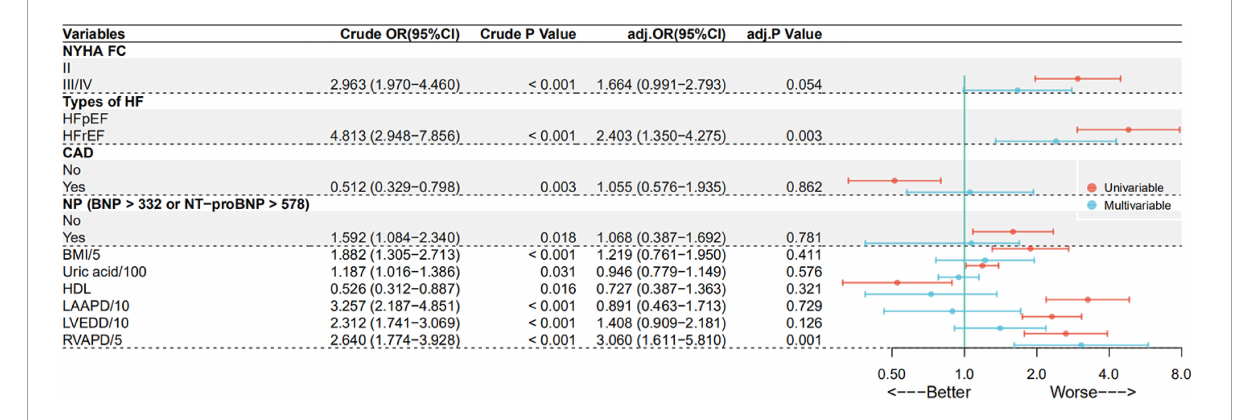
FIGURE2 Predict factors for PH-LHF in LHF patients in univariate and multivariate logistic regression